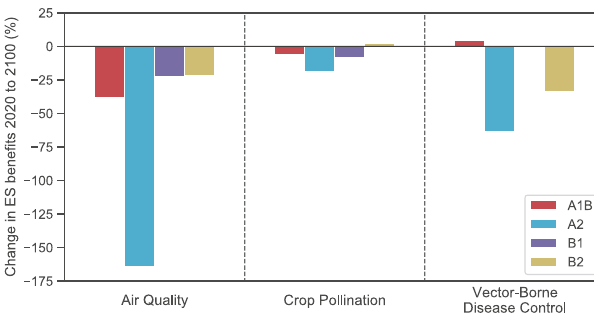
Fig. 2 Projected changes in ES bene fi ts between 2020 and 2100. Bene fi ts for each service were calculated at the county-level, then summed at the national level. Projections vary by IPCC SRES scenario, as indicated by the color of the bars. The indicators used for each of the bene fi ts are described in Table